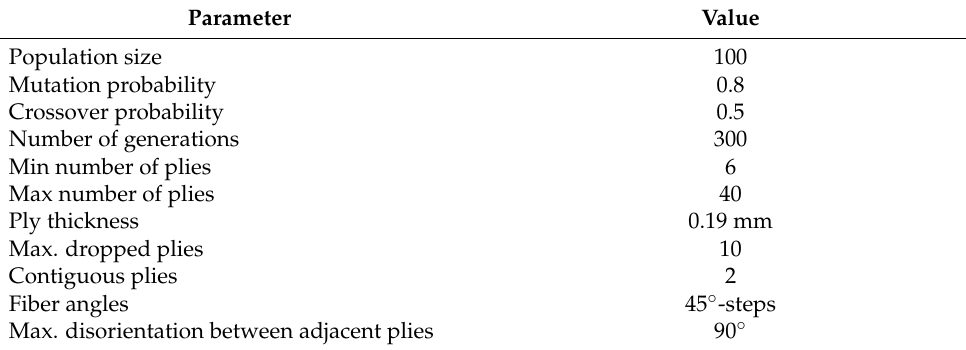
Table 3. Parameters of the genetic algorithm and laminating